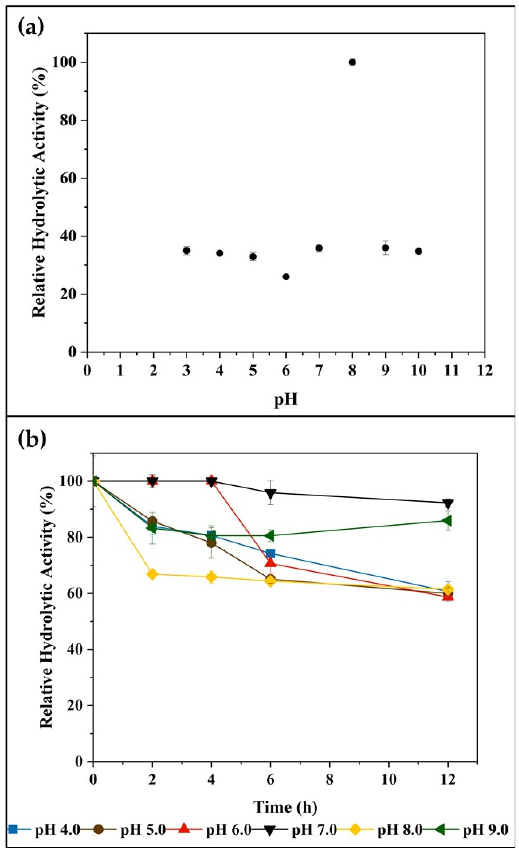
Figure 1. Characterization of lipase from A. japonicus in relation to optimal pH ( a ) and pH stability through time (until 12 h of incubation) ( b ). These experiments were performed at 30 °C. In the optimal pH, 100% is related to the highest hydrolytic activity achieved. In the pH stability studies, the initial activity obtained at time zero to each pH was considered 100% (different values for each pH values). The error bars represent the standard deviation of triplicates.